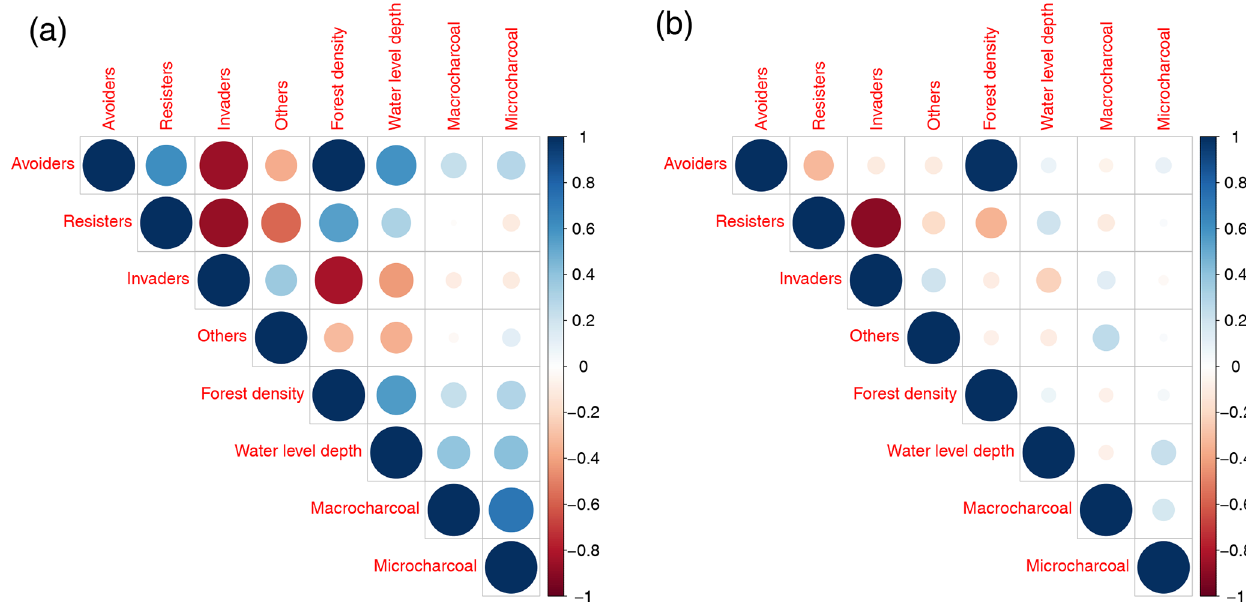
Figure 6. Correlation analysis between water table position, the main plant functional types, and the light-to-dark taiga index (forests density) as well as microcharcoal and microcharcoal for Rybnaya (a) and Ulukh–Chayakh (b) .